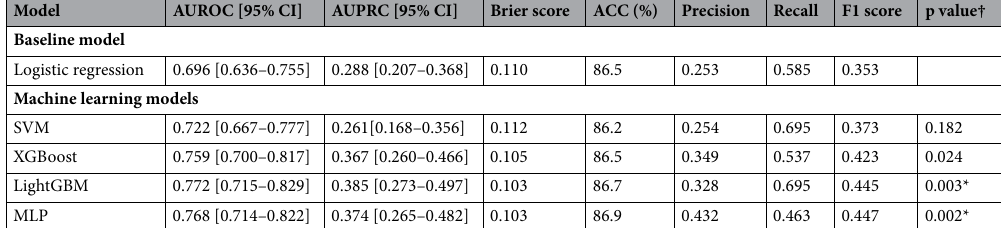
Table 1. Comparison of model performance. *Significant difference at p < 0.005. † Comparison with logistic regression on AUROC. Abbreviations: AUROC, area under the receiver operating characteristic curve; AUPRC, area under the precision-recall curve; SVM, support vector machine; XGBoost, extreme gradient boosting; LightGBM, light gradient boosting machine; MLP, multilayer perceptron.